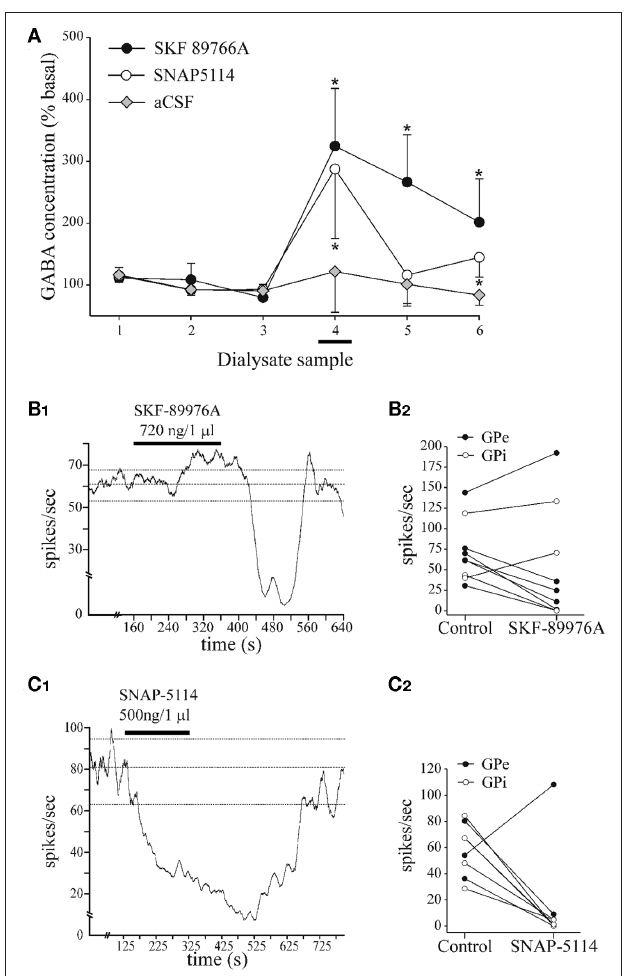
FiGurE 4 | Effects of SKF 89976A and SNAP 5114 on GABA levels in GPe and pallidal discharge rate in monkeys. (A) Dialyzate samples were collected every 10 min. SKF 89976A or SNAP 5114 were administered during sample 4 (horizontal bar). Data area means ± SD from three experiments for each treatment in a single monkey. Difference from ACSF experiments (Mann– Whitney UU test): * P < 0.05. (B1) Example of effect of SKF 89976A on discharge rate of a GPe cell. (B2) Discharge rate of GPe and GPi cells during baseline period and at the point of maximal effect of SKF 89976A. (C1) The discharge rate of this GPe cell is inhibited after administration of the GAT-3 blocker, SNAP 5114. (C2) The discharge rate of GPe and GPi cells during baseline period and at the point of maximal effect of SNAP 5114 injection. In (B1,C1) , horizontal bars indicate duration of drug infusions. Dashed lines represent mean discharge rate ± 2 SD. For more details see Galvan et